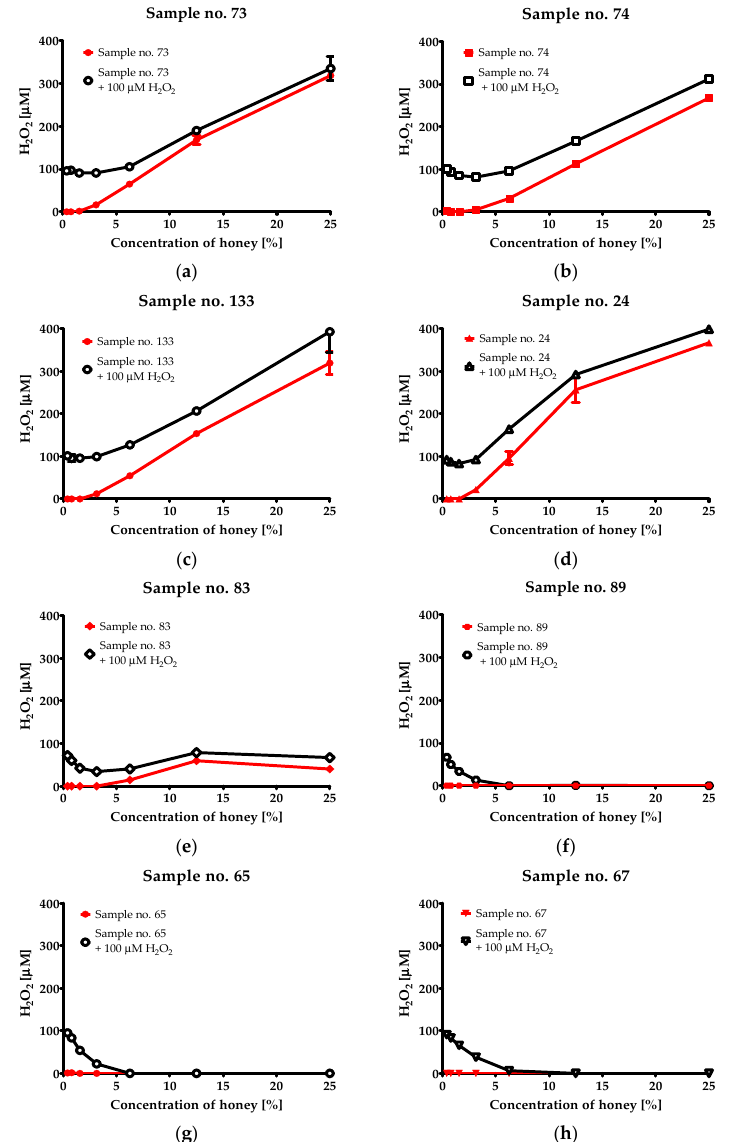
Figure 4. Investigation of hydrogen peroxide concentrations in honey solutions prepared in 100 µ M H 2 O 2 as a solvent; ( a , b ) lime tree ( c , d ) multi-floral ( e , f ) buckwheat ( g , h ) rape honey.